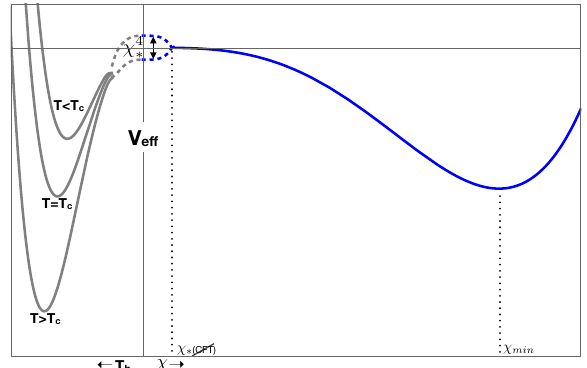
Figure 2 . A 1D illustration of the potential describing the two phases of the crunching CFT sector. The potential is obtained by gluing together the zero temperature dilaton potential, V ( χ ) (on the right of the vertical line at χ = T h = 0 ) and the thermal potential of the black brane as a function of its Hawking temperate, T h (on the left). The gluing is done when both the IR brane and the black brane horizons are taken to infinity. At large χ , the Goldberger-Wise potential is dominating. At χ ’ χ ∗ and below, the explicit breaking of the conformal symmetry becomes sizeable and deforms the potential, introducing a barrier with a typical scale χ ∗ . In our scenario, the explicit breaking arises from an additional confining gauge group in the bulk of the